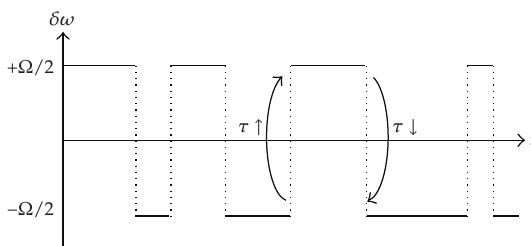
Figure 1: Frequency fluctuation of the QD emission line as a function of time in the presence of a single random telegraph. Ω is the Stark shift of the QD line due to the electric field created by the charge carrier in the defect located in the QD vicinity. τ ↓ and τ ↑ are the characteristic time constants of the jump